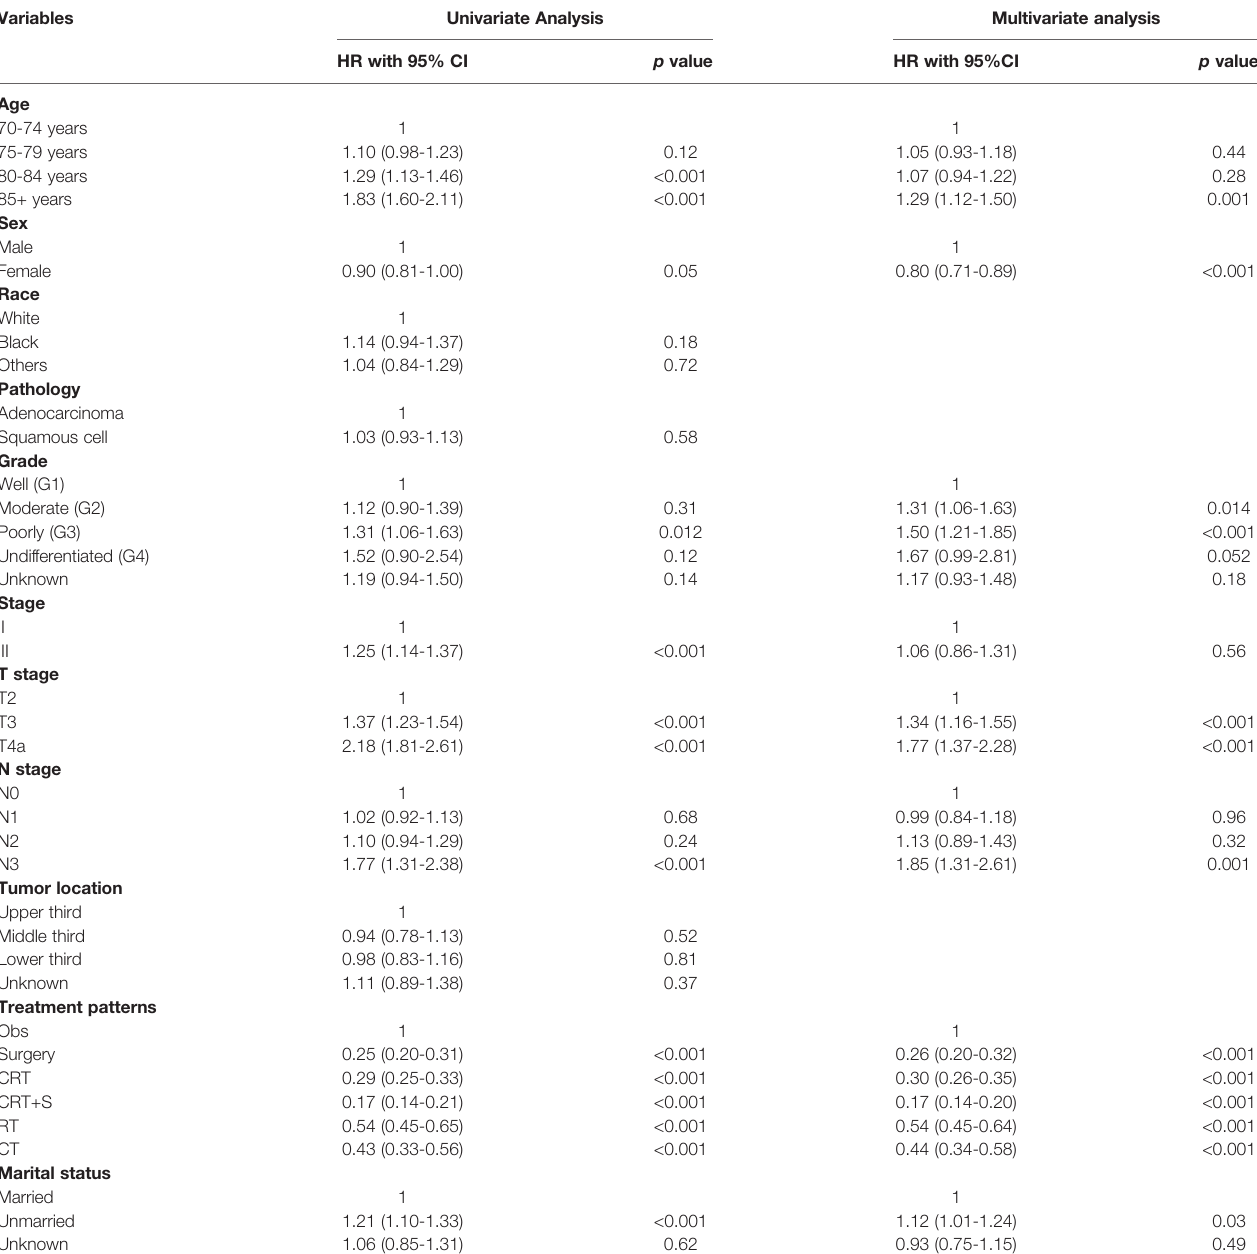
TABLE 2 | Univariate Analysis and Multivariate Cox regression analysis of OS in in elderly EC patients with ≥ 70